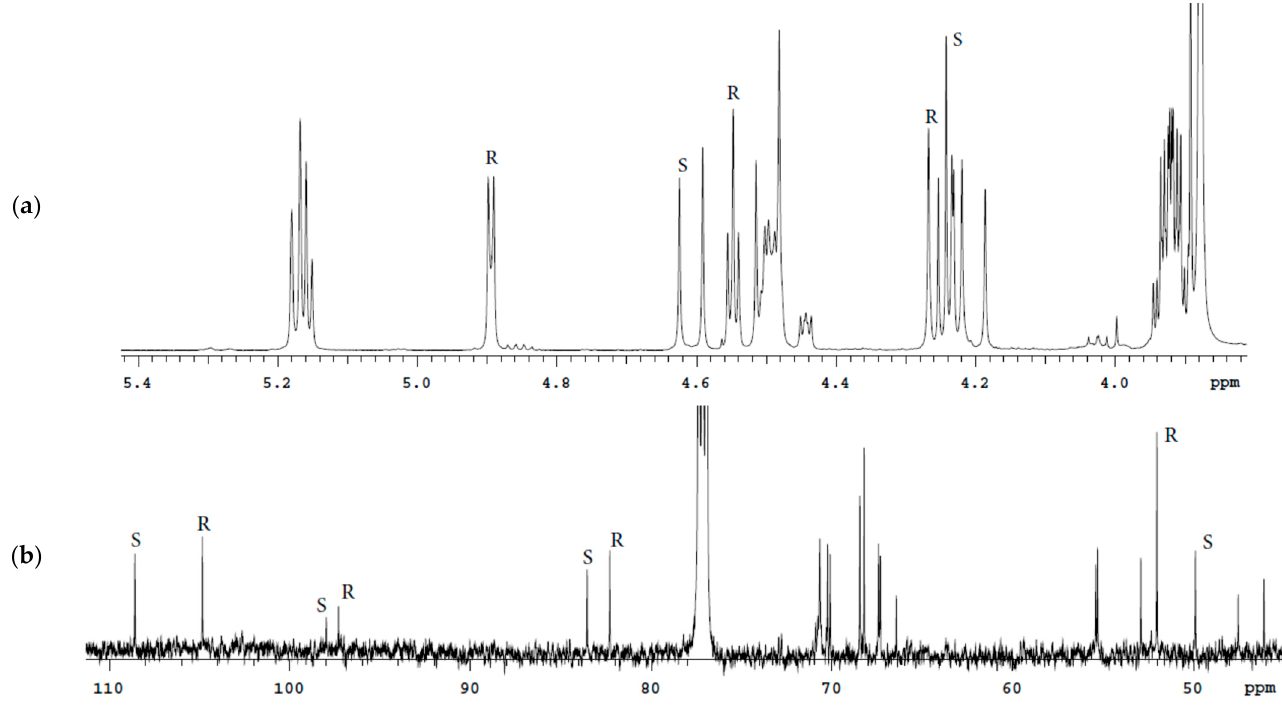
Figure 7. 1 H ( a ) and 13 C ( b ) spectra fragments of the Bud nasal spray solution in CDCl 3 with characteristic signals of 22 R and 22 S epimers.